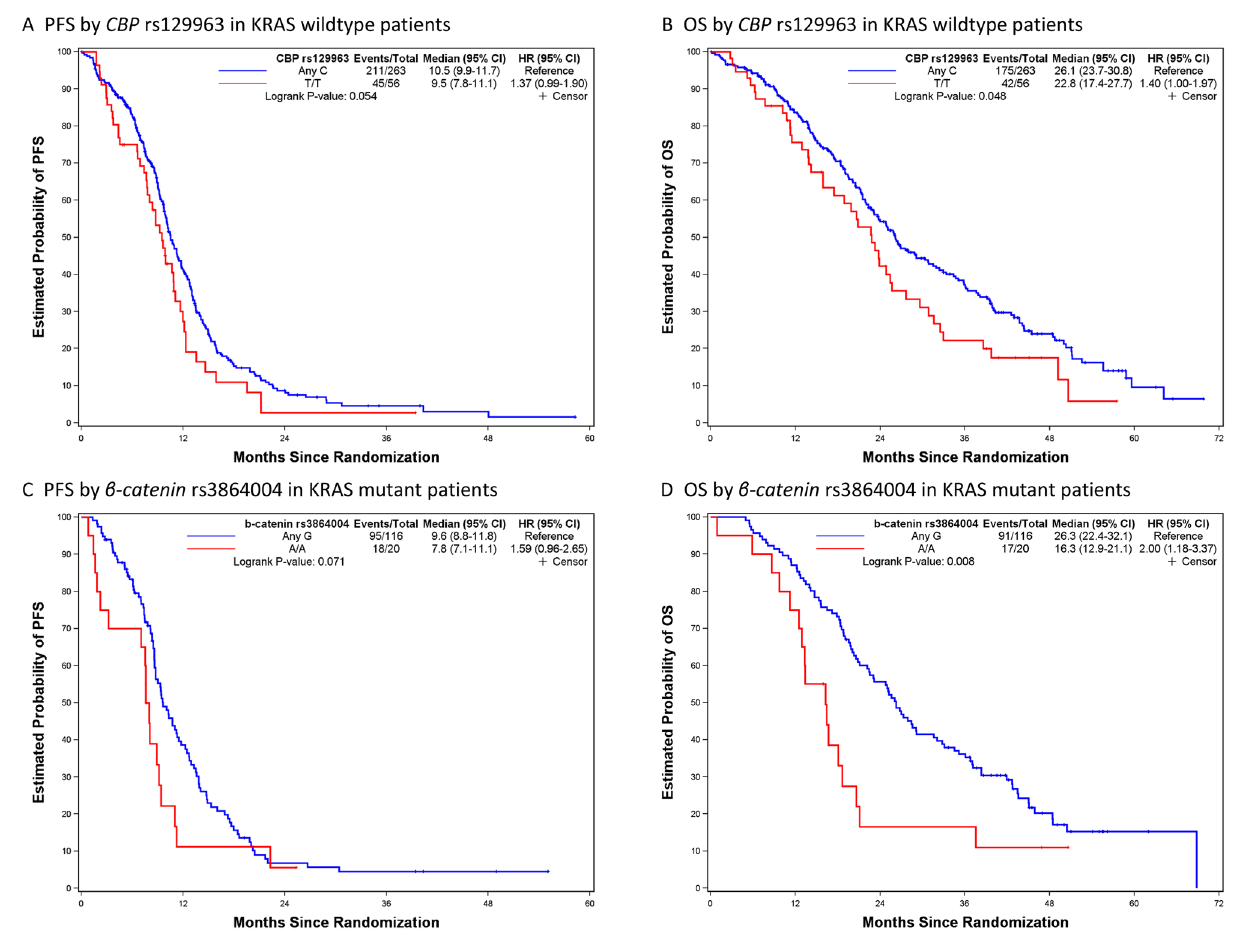
Figure 5. Kaplan–Meier curves and log-rank test for Wnt SNPs predictive of PFS and OS in KRAS wild-type and mutant mCRC patients: ( A ) KRAS wildtype patients with CBP rs129963 T/T variant have shorter PFS (9.5 vs. 10.5 mo; p = 0.054) and ( B ) OS (22.8 vs. 26.1 mo; p = 0.048) compared to those with Any C allele. ( C ) KRAS mutant patients with β-catenin rs3864004 A/A genotype have shorter PFS (7.8 vs. 9.6 mo; p = 0.071) and ( D ) OS (16.3 vs. 26.3 mo; p =